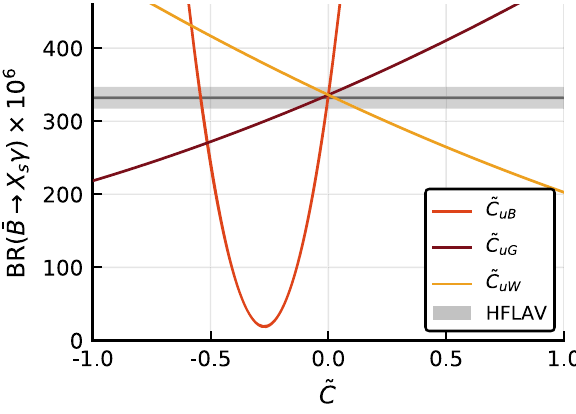
Fig. 6 Parametrizations of the fiducial t ¯ t γ cross sections for (left) the single-lepton channel and (right) the dilepton channel, represented as slices of the phase space where only one of the Wilson coefficient is